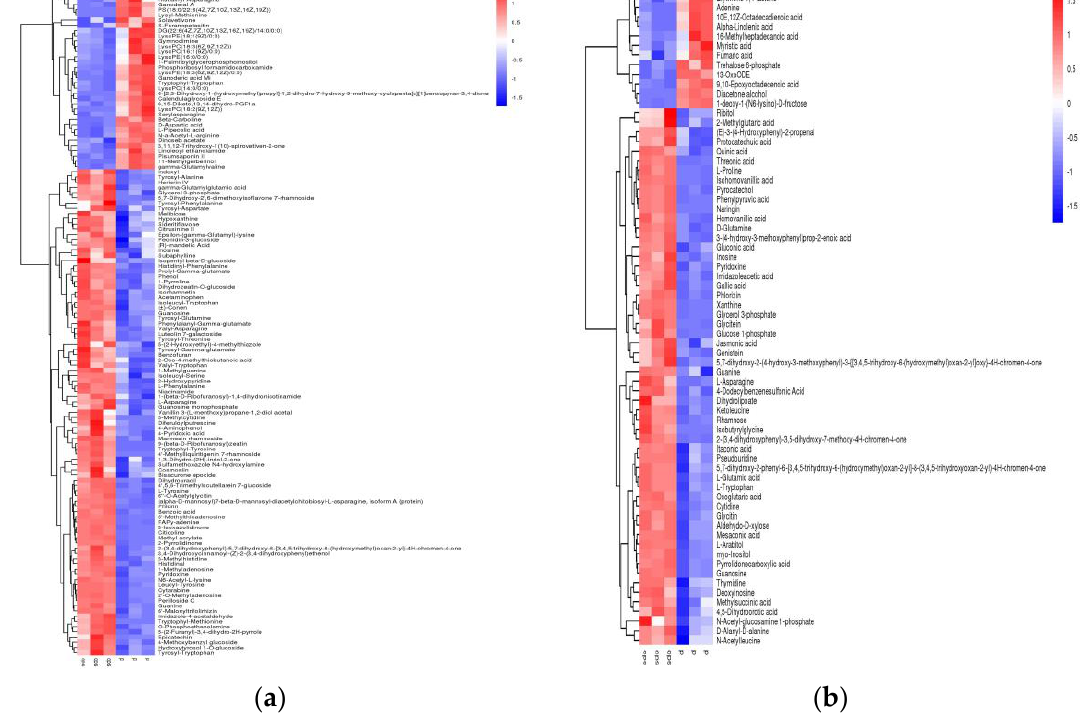
Figure 5. Heat map of hierarchical cluster analysis of differential metabolites of steamed and cooked black beans. ( a ) Positive ion mode. ( b ) Negative ion mode.